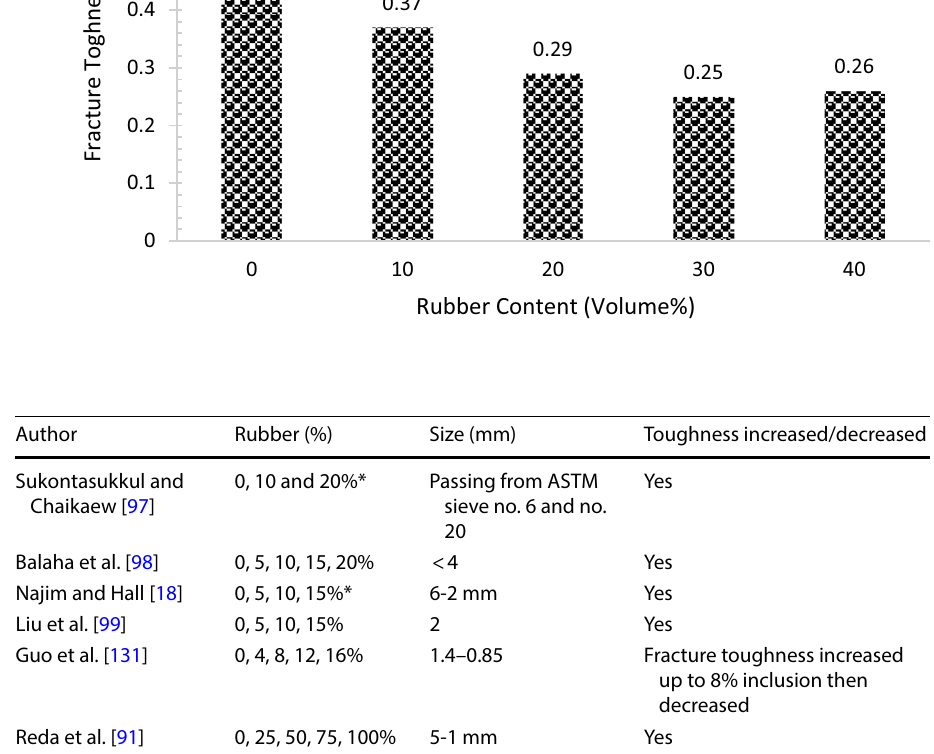
* Sign shows rubber inclusion by weight in